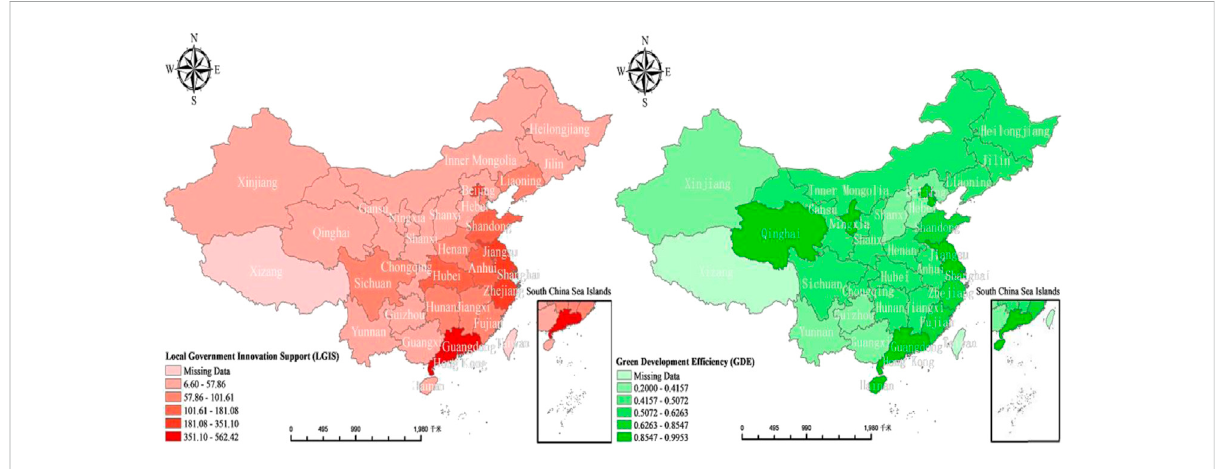
FIGURE 1 Spatial distribution pattern of LGIS expenditure and